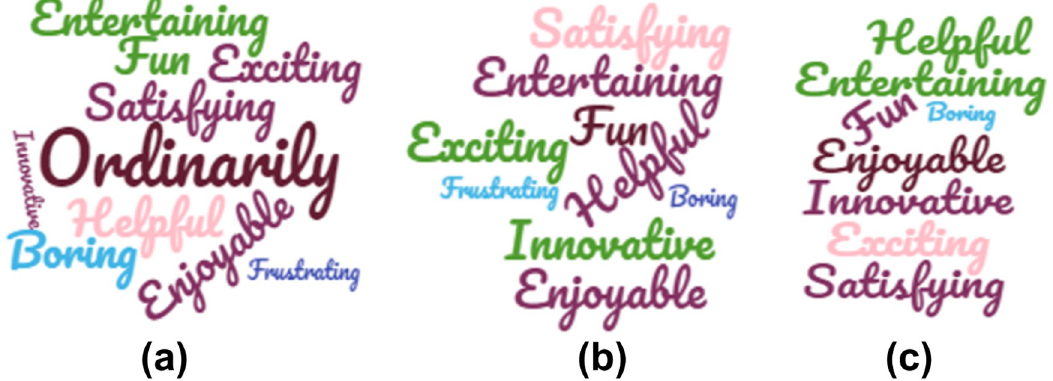
Fig 22. Keywords used by the participants to describe: (a) Manual AUI, (b) Automatic AUI, and (c) Hybrid